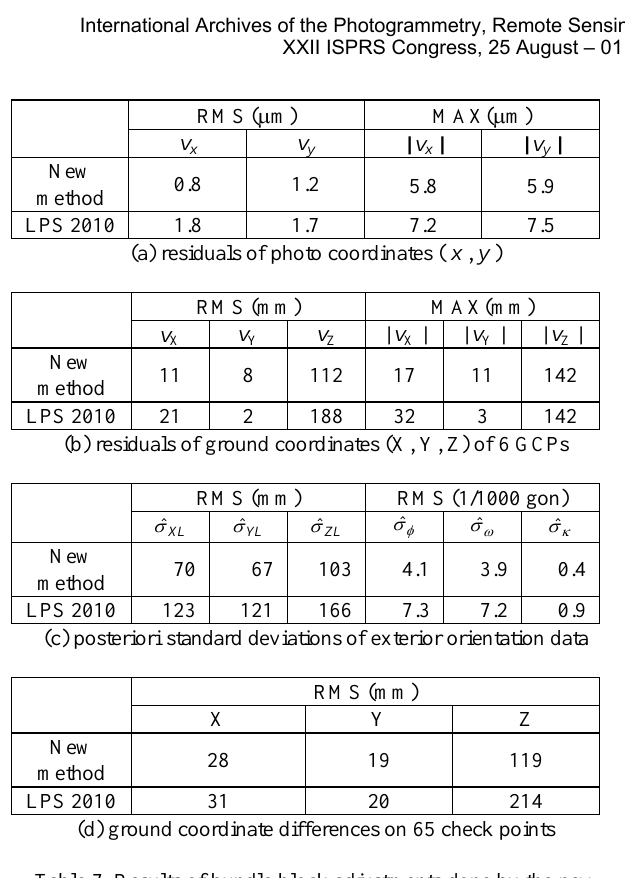
Table 7. Results of bundle block adjustments done by the new method and